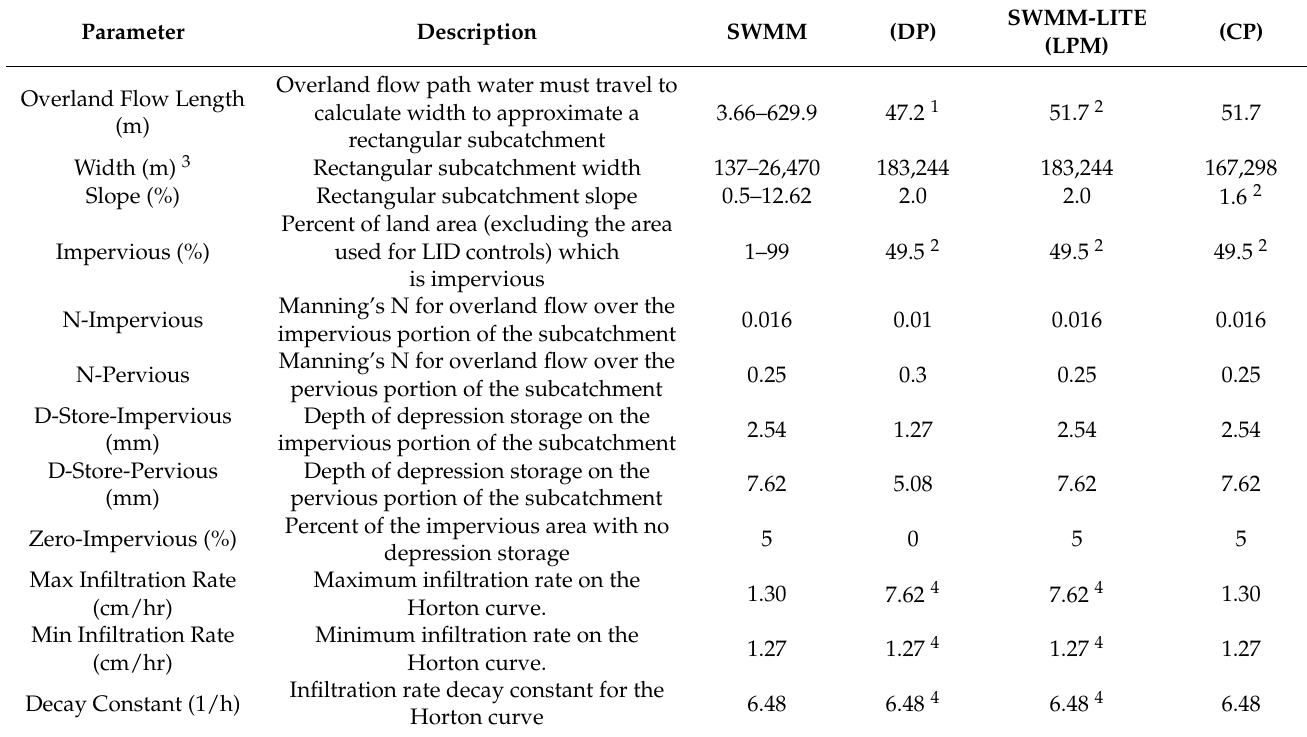
Table 1. Input Parameters Applied to SWMM and SWMM-LITE